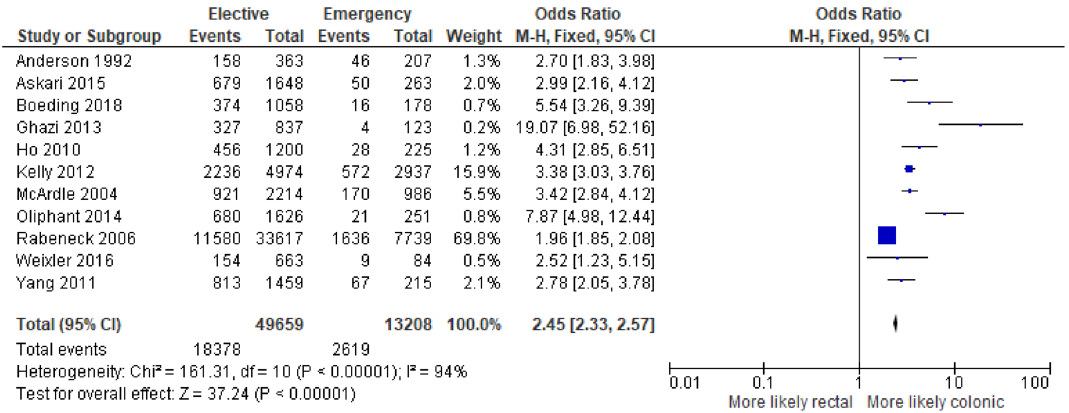
Figure 2. Association between tumour location (rectal vs colonic) and emergency presentation—Forest